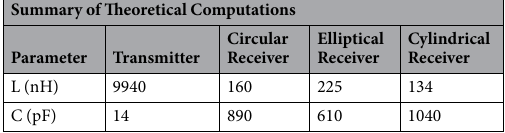
Table 1. Summary of theoretical computations. A Class E PA was implemented for the transmitter for its capacity to maintain high efficiency with low DC input current and high AC output current into the tank circuit. The Class E PA was designed based on principles described by Sokal 42 . In the selection of the MOSFET, essential parameters included the low on-resistance (R DS(ON) ), low output capacitance (C oss ), and low gate threshold voltage (V GS(th)